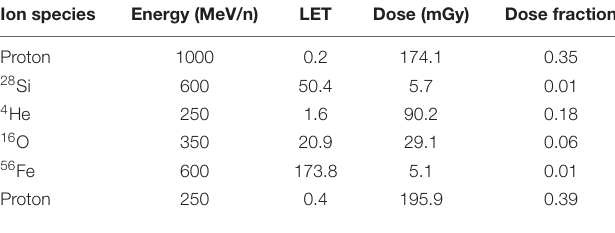
TABLE 1 | Break-down of the simplified five-beam radiation